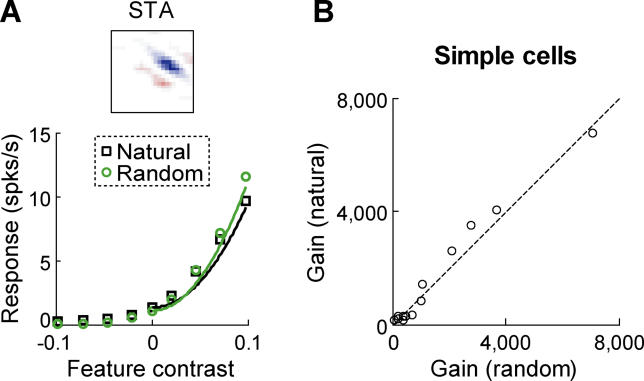
Feature Sensitivity of Simple Cells in Response to Natural Images and Random Stimuli(A) Contrast-response function for the preferred feature (inset above) of a simple cell. Curves: fits of data with quadratic functions (for positive feature contrasts only).(B) Gain of contrast-response function, as in Figure 3B (n = 14, from 14 cells).